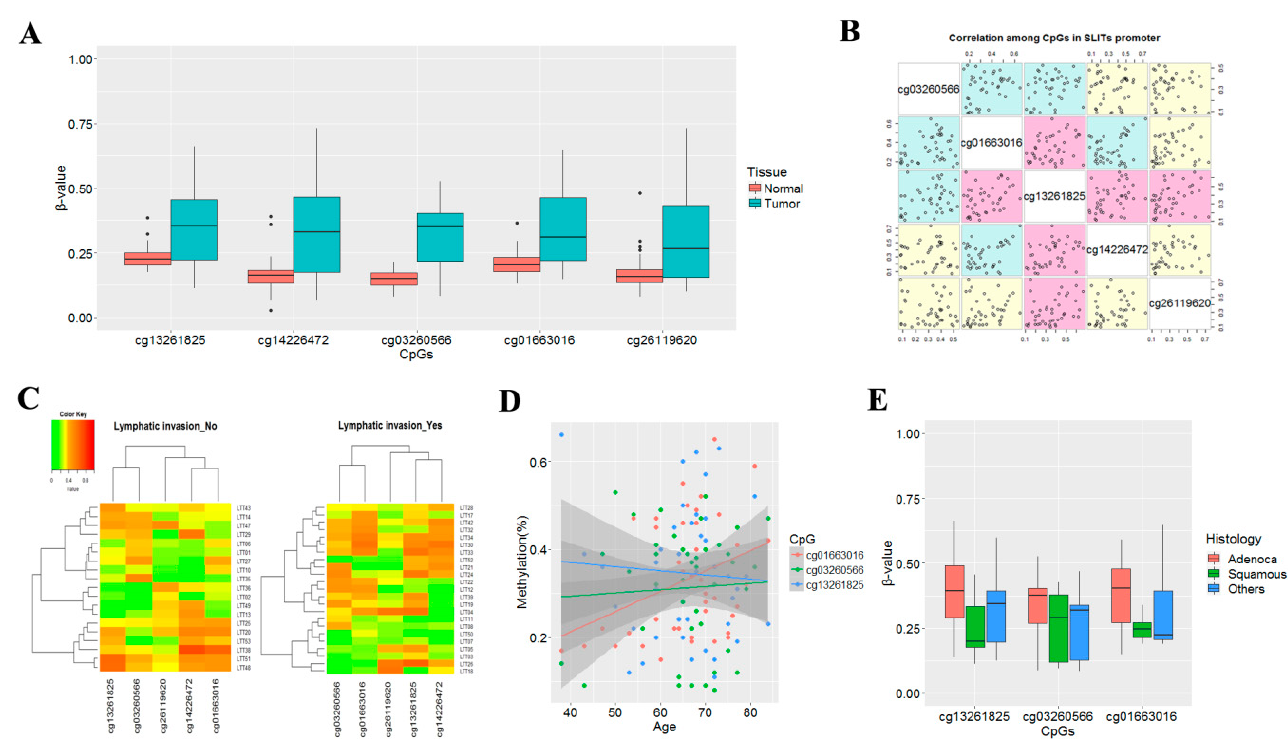
Figure 1. Relationship between aberrant methylation of SLIT genes and clinicopathological features in 42 patients with NSCLC. ( A ) Methylation levels of five CpGs at the CpG island regions of SLIT1 , SLIT2 , and SLIT3 genes were compared between tumor and matched normal tissues from 42 NSCLC patients. Y-axis indicates β -value. ( B ) Correlation among methylation levels of five CpGs was analyzed for 42 tumor tissues using Spearman’s correlation coefficients. Magenta color indicates p < 0.05. ( C – E ) Methylation levels of CpGs at SLIT1 , SLIT2 and SLIT3 genes were compared according to lymphatic invasion ( C ), age ( D ), and histologic subtypes ( E